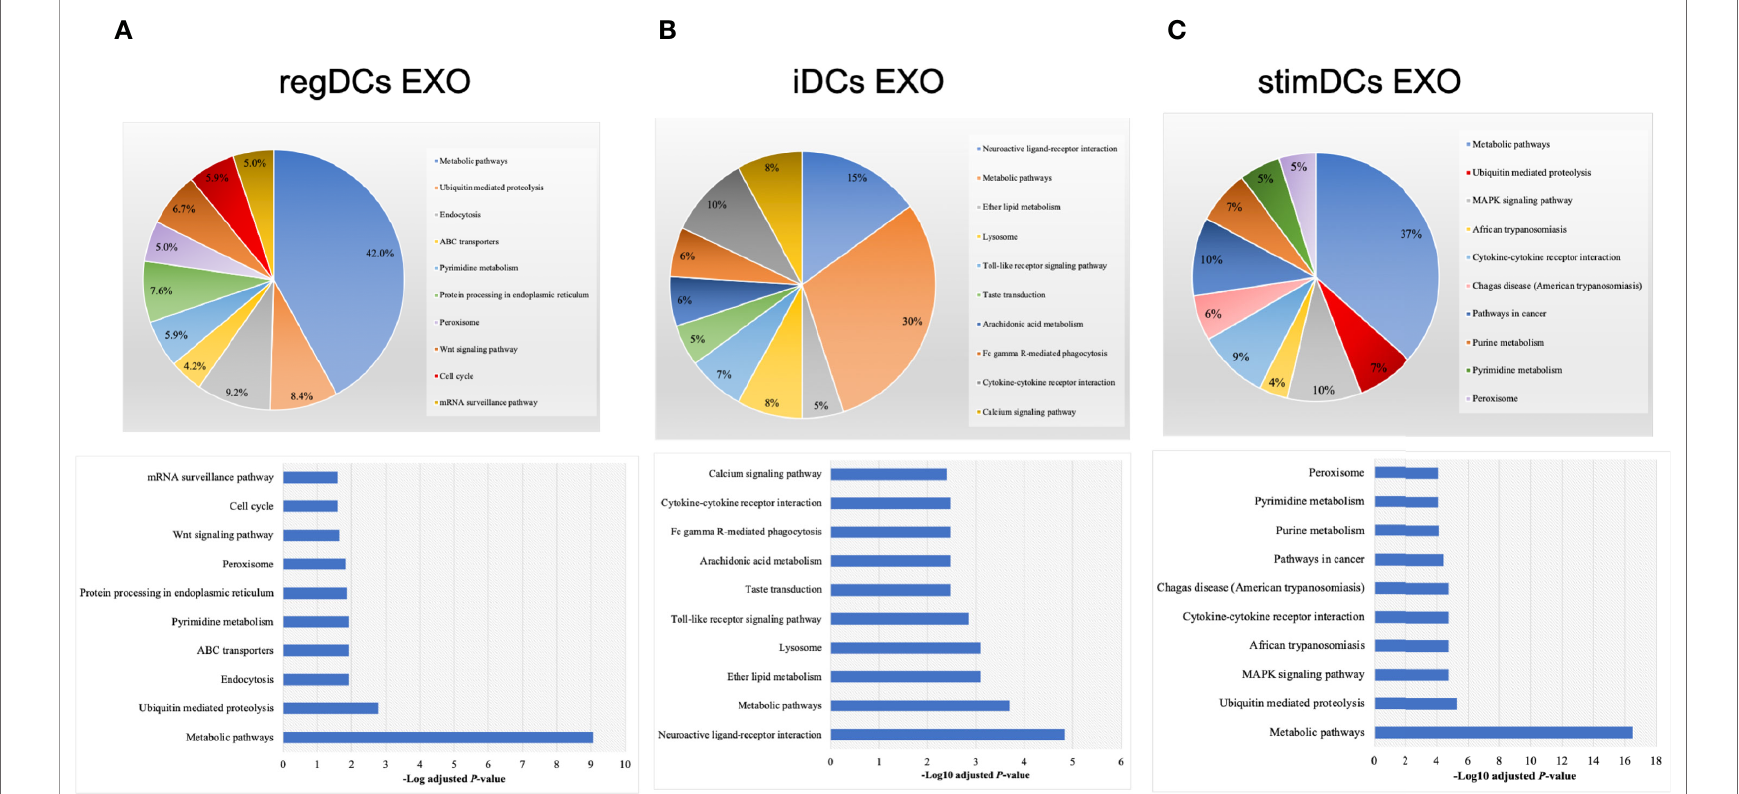
FIGURE 3 | KEGG pathway enrichment analysis of the uniquely expressed proteins listed on their percentage (upper panel) and level of signi fi cance (lower panel) in (A) regDCs EXO, (B) iDCs EXO, and (C) stimDCs